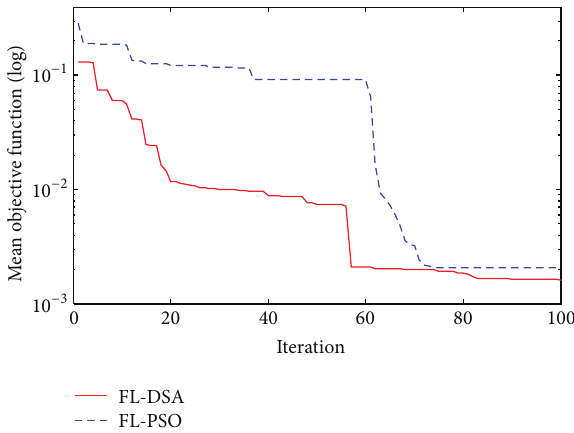
Figure 10: Performance comparisons based on FL-DSA and FL-PSO.